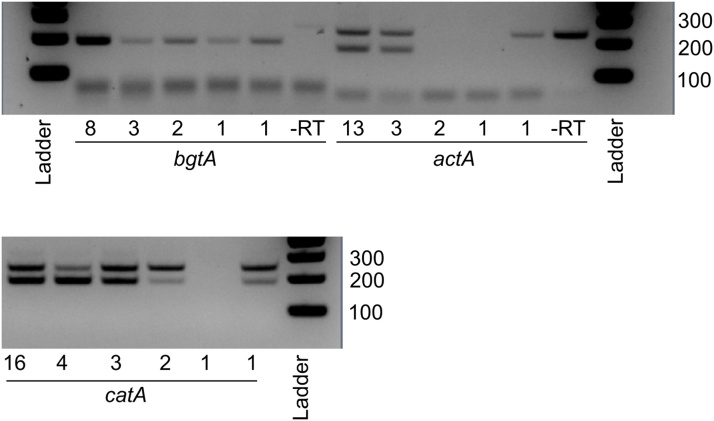
Gel electrophoresis (3 % gel) of amplified cDNA from small numbers of A. niger conidia. Three genes were analyzed (bgtA, actA and catA). The number of conidia extracted is stated below each lane. For the –RT controls, 22 and 26 conidia were extracted for bgtA and actA respectively. Ladder: 100 bp ladder (New England Bioscience), band sizes indicated at right of pictures. For actA and catA, the larger-sized fragment corresponds to gDNA. For bgtA, a band size of 190 bp is expected for amplification of cDNA, and a band size of 260 bp for amplification of gDNA (faintly visible in the –RT control).